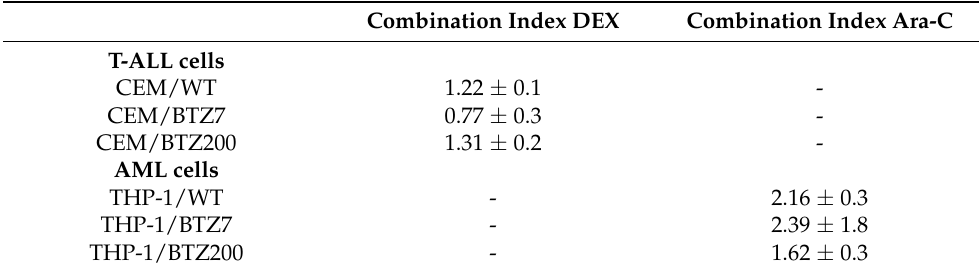
Table 2. Mean combination index (CI) ( ± SD) of IXA combined with dexamethasone (DEX) and cytarabine (Ara-C) in BTZ-sensitive and BTZ-resistant leukemia cells.